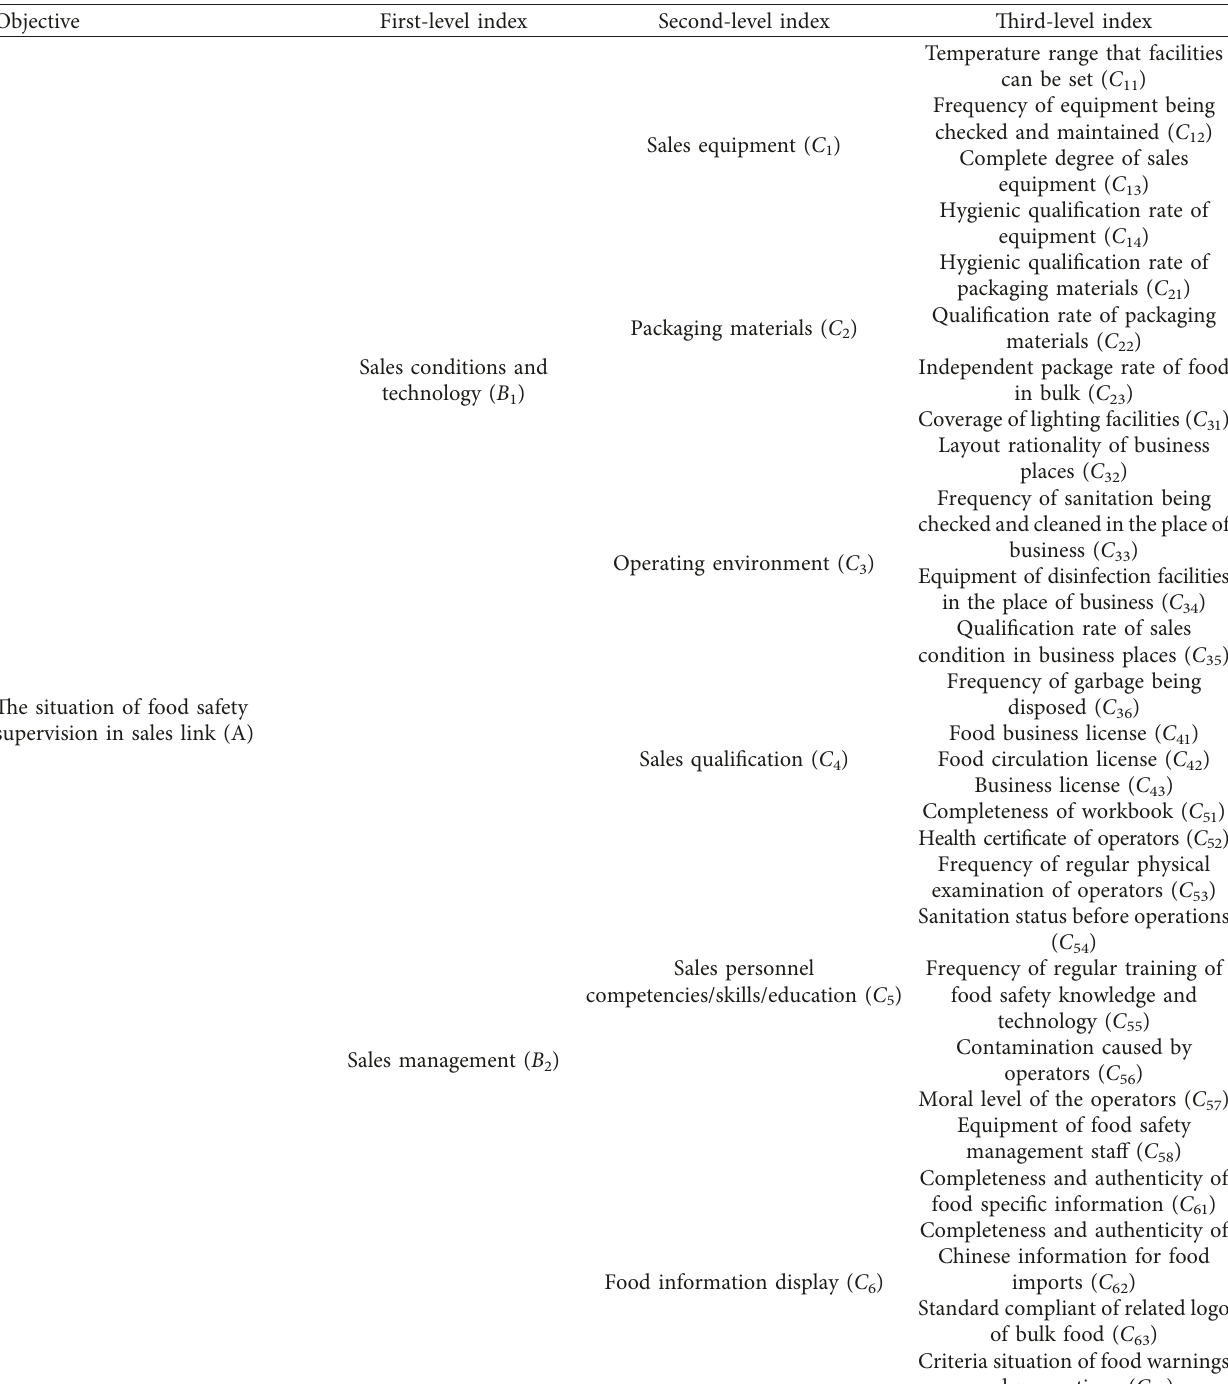
Table 1: Index system for the situation of food safety supervision in the sales